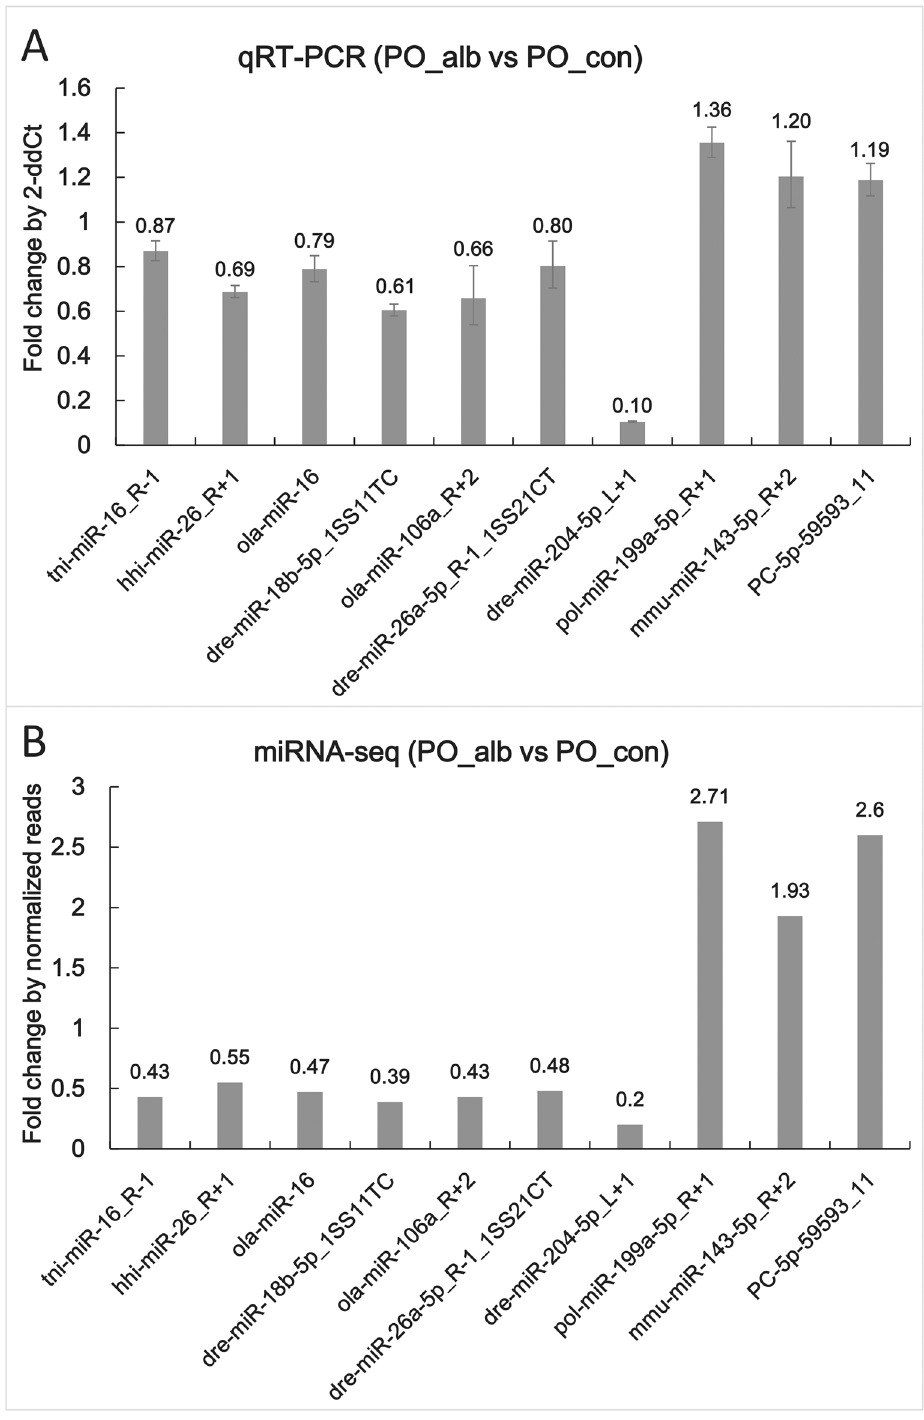
Fig 8. The expression levels of 10 randomly selected miRNAs in qRT-PCR and miRNA-seq. The expressionfold changesof 10 P . olivaceus miRNAs in PO_alb versus PO_con detected by poly (A)-tailed qRT-PCR and high-throughput sequencing are shown in A and B, respectively. In qRT-PCR analysis, 5s rRNA expressionlevels were used for the internalcontrol, and values are indicatedas means ± standarderror (SE) derived from triplicate